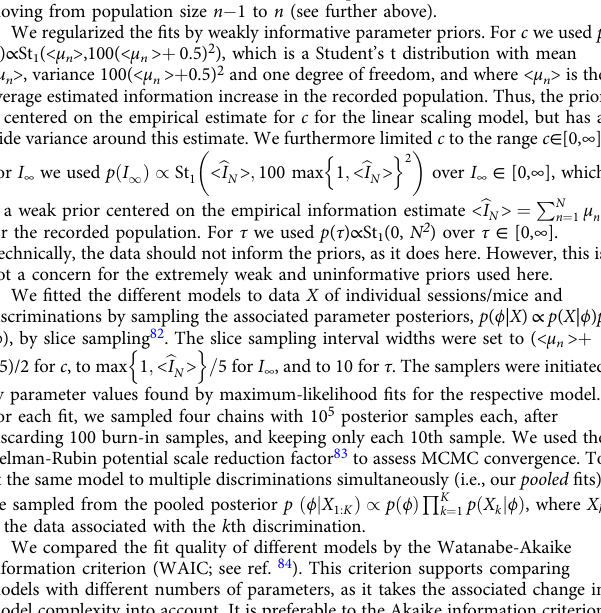
this fraction depends only the relationship between I lo 1 and I hi 1 , as quanti fi ed by α , but not on their individual values. Figure 8. All estimates in Fig. 8 are averages across 10 random splits of the recorded data. For each split, half of the trials were used to compute the principal dimensions, Q train , using the spectral decomposition Σ train ¼ Q train D train Q T train , where D train is diagonal, Q train is the matrix of unit eigenvectors, and we denote the n th column vector of Q train by q n, train . The second half of trials was used to fi nd f' test and Σ test , from which we computed the shown estimates as follows. The noise variance associated with the n th principal dimension was found by q T n ; train Σ test q n ; train . The f ′ alignment to the n th (cid:1) (cid:3) 2 = f 0 T test f 0 test . principal dimension was found by cos 2 α n ð Þ ¼ q T n ; train f 0 test